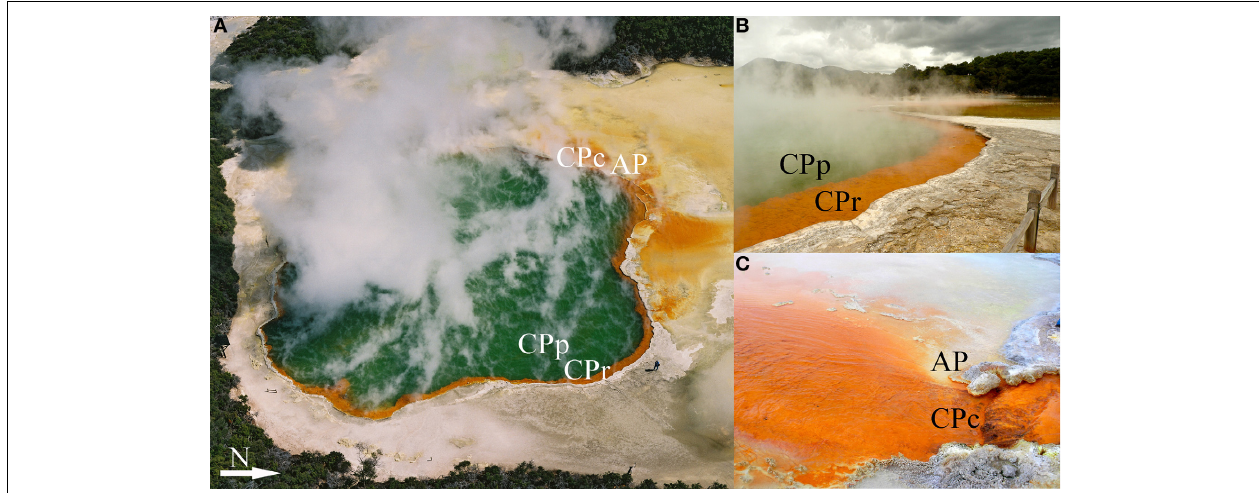
FIGURE 1 | Sampling sites (with abbreviations) at Champagne Pool, Waiotapu, New Zealand. (A) Aerial view of Champagne Pool, photo credit: courtesy of GNS Science (B) CPp, central pool; CPr, rim of pool; (C) CPc, outflow channel (40cm wide; 5cm deep); AP, “Artist’s Palette” terrace.